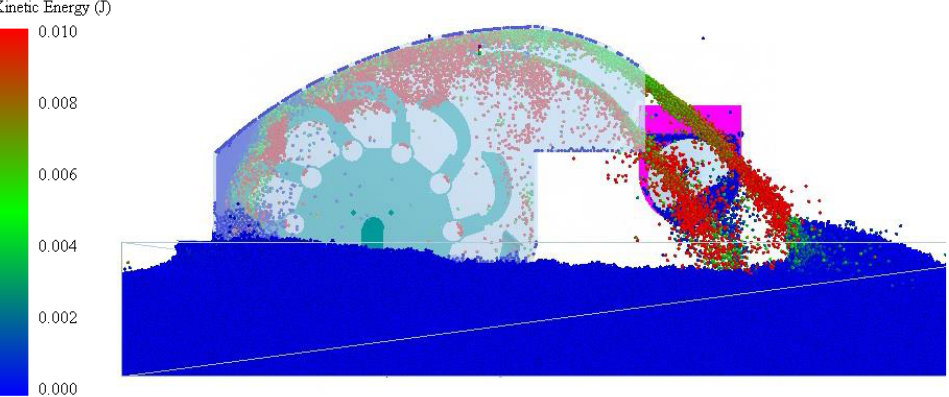
Figure 7. Soil fertilizer collision mixing mulch kinetic energy map.